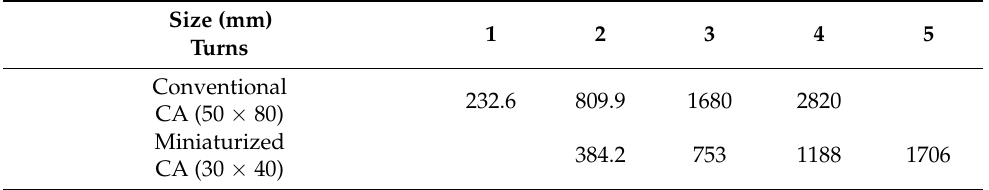
Table 1. The inductance of conventional and miniaturized CAs based on variable turns. Size